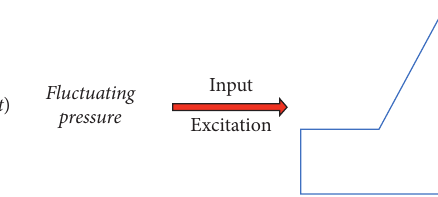
Figure 1: Relationship between excitation and response of the slope dynamic